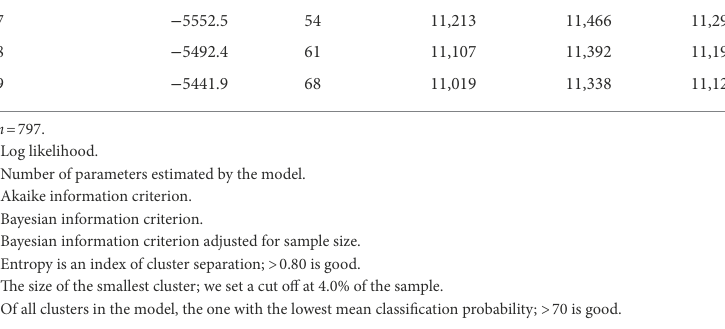
TABLE 3 Mean temperament scale score ( z score) for Each Cluster: 7 cluster